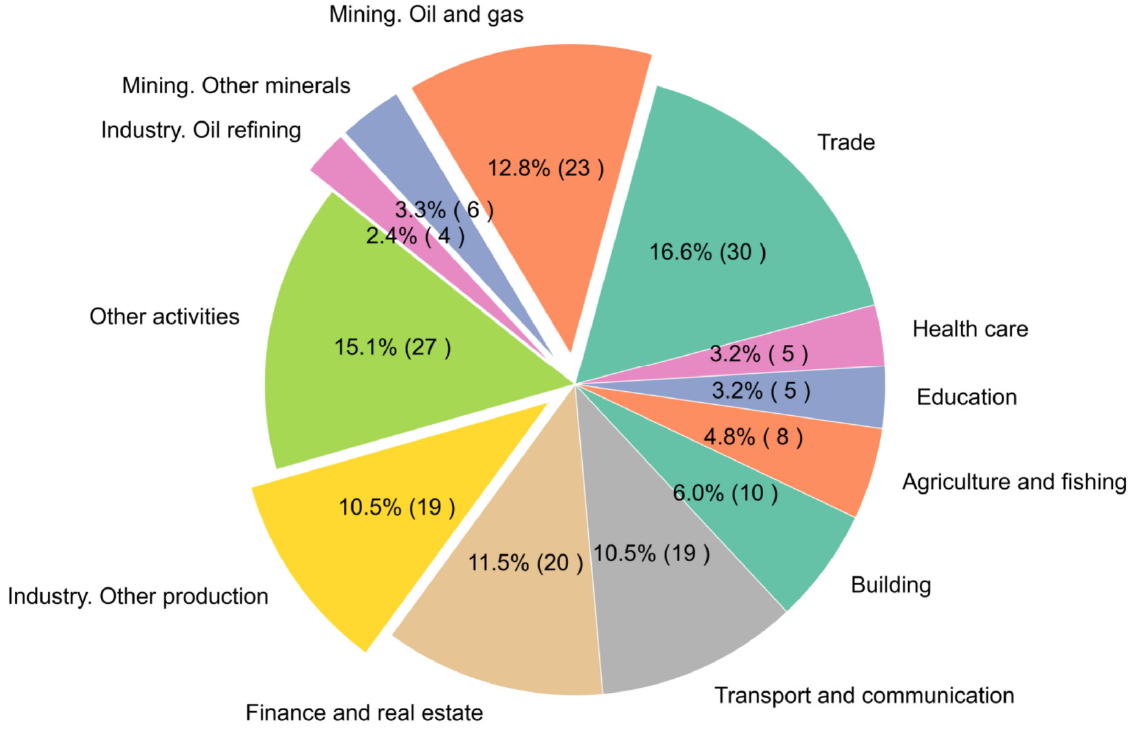
Figure 11. Structure of the GDP of Kazakhstan. Source: Generated by the authors.